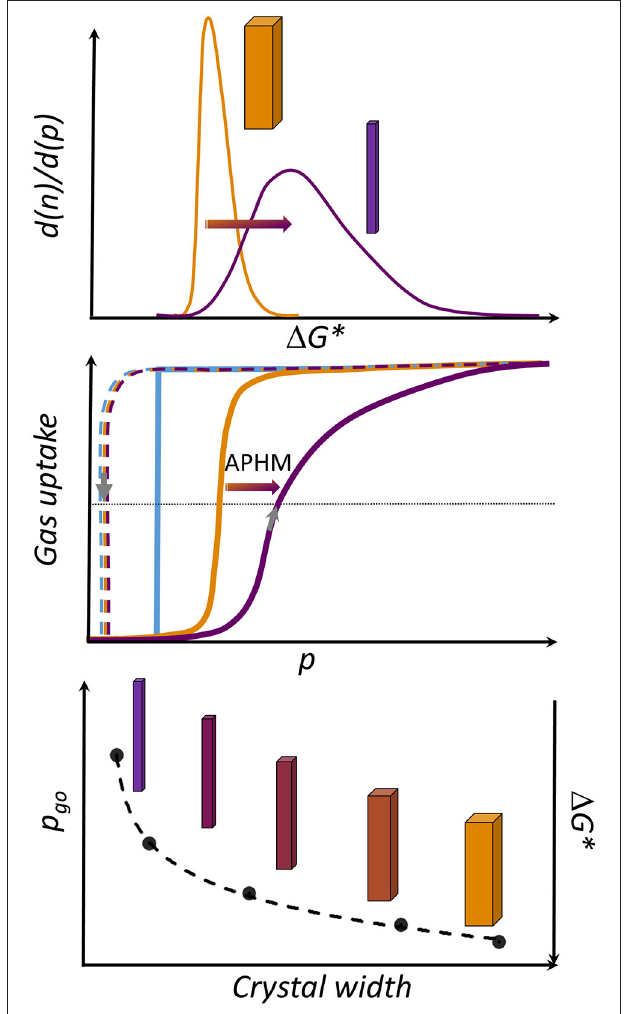
FIGURE 5 | Overview of crystal-size-dependent behavior in DUT-8(Ni). (Top) Distribution of activation energies ( 1 G*) in the sample, depending on the crystal width (W). (Middle) Rectangular gate opening isotherm (blue) corresponding to an ideal single grain-switching event. Orange: schematic representation of the isotherm usually obtained for macro-sized crystals. Violet: typical isotherm characteristic for micron-sized particles (adsorption: solid line, desorption: dashed line). (Bottom) Dependence of the gate opening pressure from